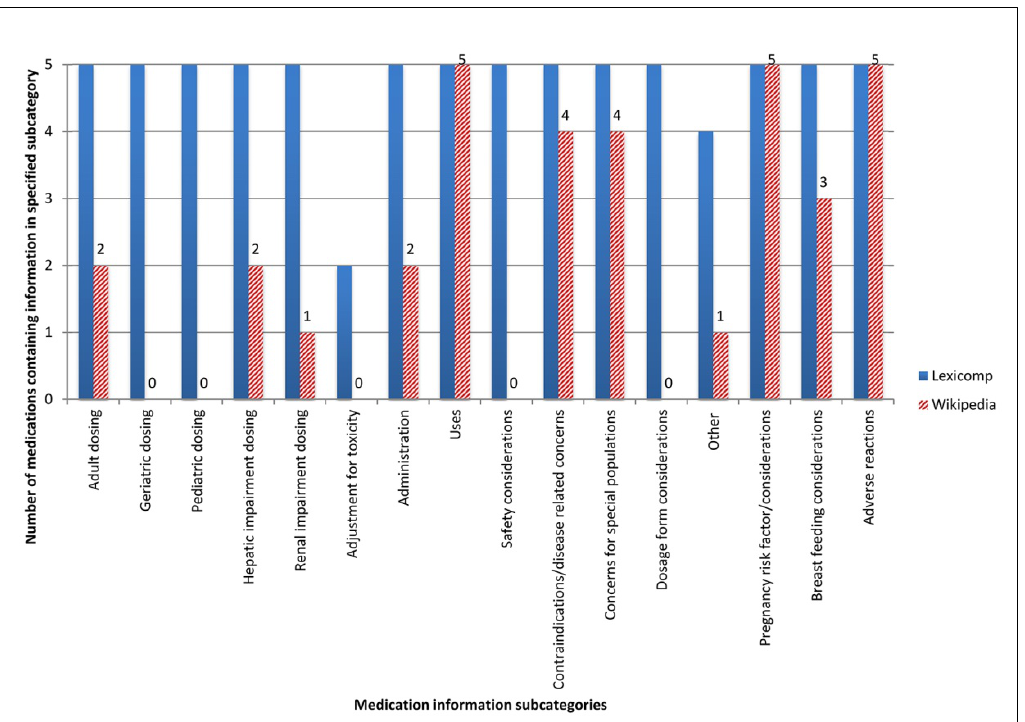
Figure 1 Number of medications containing information in specific medication information